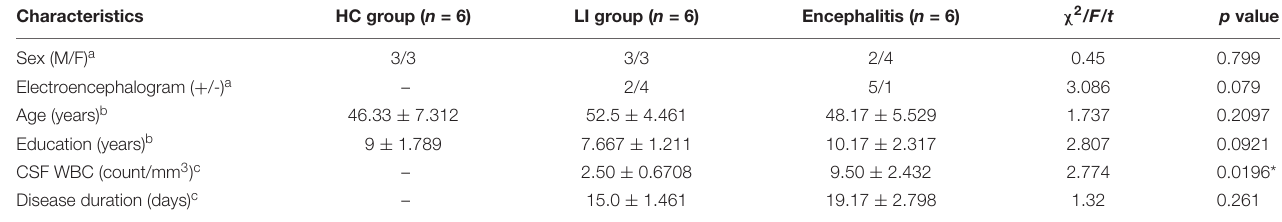
TABLE 1 | Demographic characteristics of the